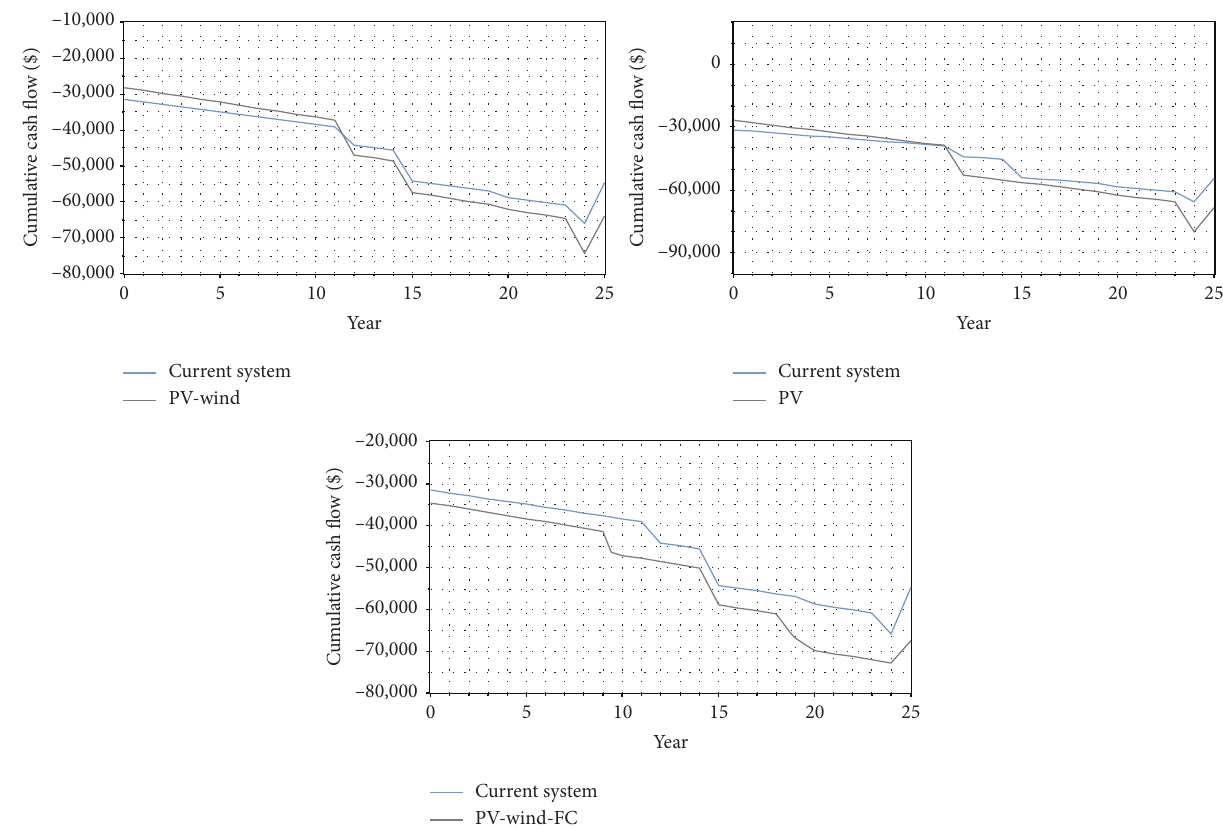
Figure 16: Current system compared to base